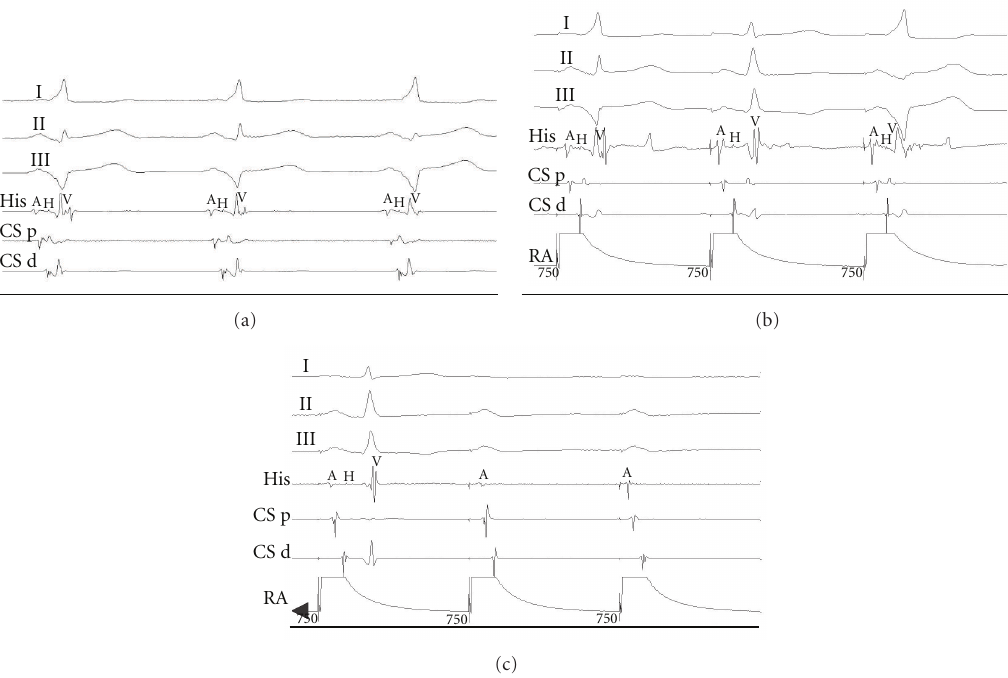
Figure 2: Surface ECG and intracardiac electrograms during the second electrophysiologic testing. (a) During sinus rhythm. A short PR interval followed by a wide QRS is clearly seen. Note short HV interval on the His electrogram. (b) During right atrial pacing. The first and third beats are with the short PR and the wide QRS, and second paced beat is a normal sinus beat. (c) After adenosine bolus. Note transient complete AV block and no QRS widening. His, His electrogram; CSp, electrogram from the proximal pairs of the coronary sinus catheter; CSm, from middle pairs; CSd, from distal pairs; RA, electrograms from a catheter located in high right atrial